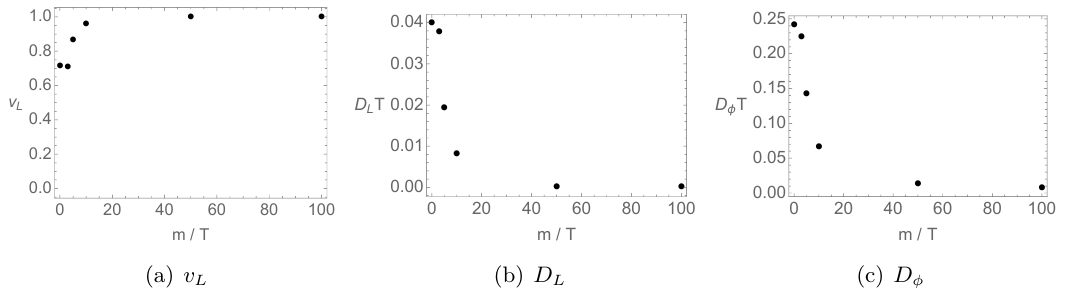
Figure 3 . Coefficients of dispersion relations of the SSB, ( v L , D L , D φ ), with various m/T